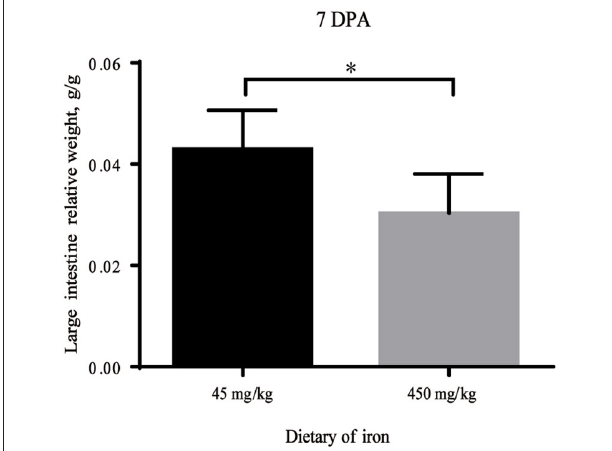
FIGURE 2 | Large intestine relative weight with different levels of ferrous sulfate. * indicates p < 0.05, n = 12. 7 DPA indicates “day 7 post administration,” which is day 28 of the whole experiment cycle.